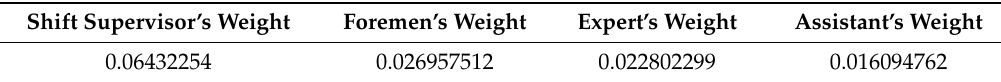
Table 3. Seniority-based ANP weights ( t i ) of the